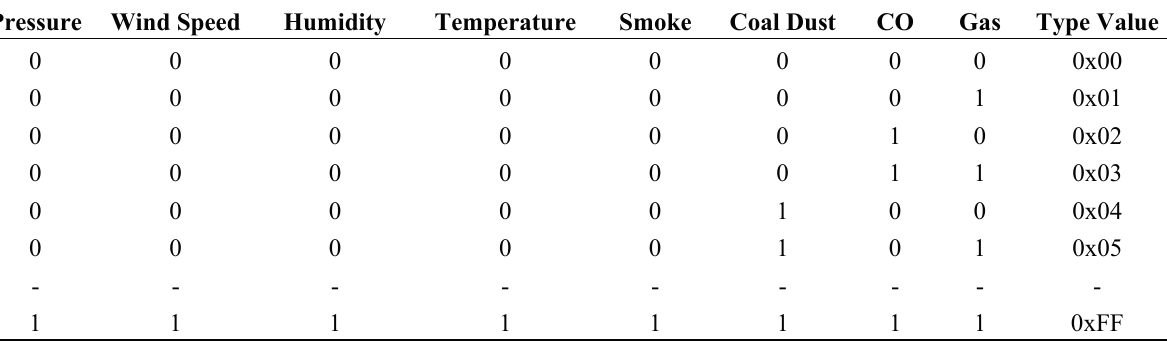
Table 4. Relationship between type-value and parameter